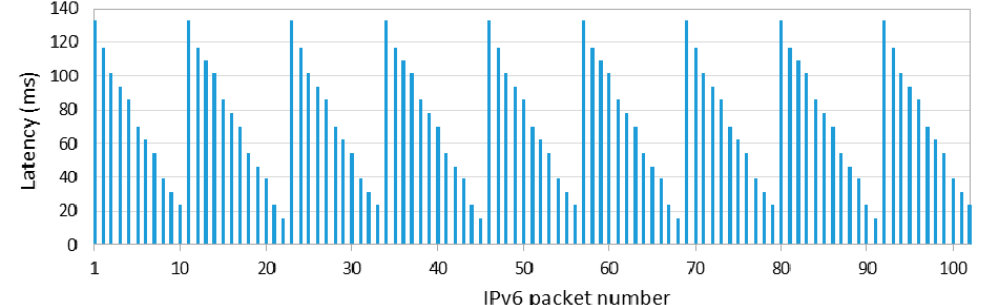
Figure 4. One-hop IPv6 packet delivery latency when the sender (the 6LN in our testbed) is also the packet source (for connInterval = 125 ms).